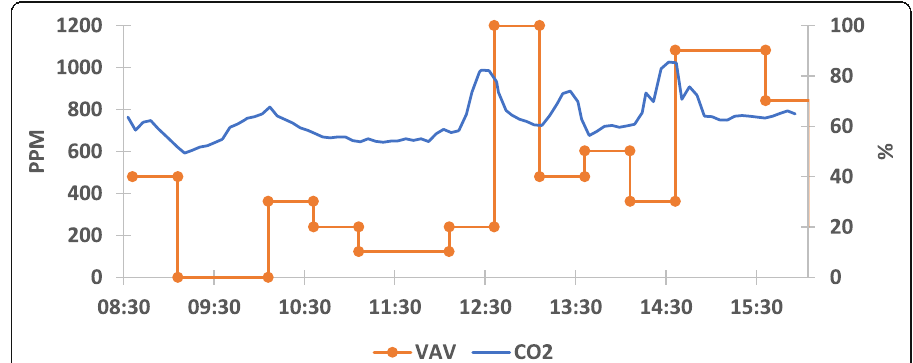
Fig. 9 CO2 levels and VAV damper position observed on December 14th, 2018 during Zone Control Application